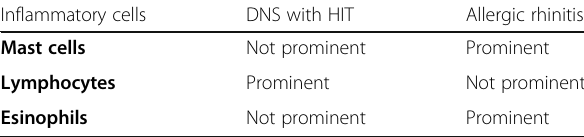
Table 4 Inflammatory cells in our studied specimens Inflammatory cells